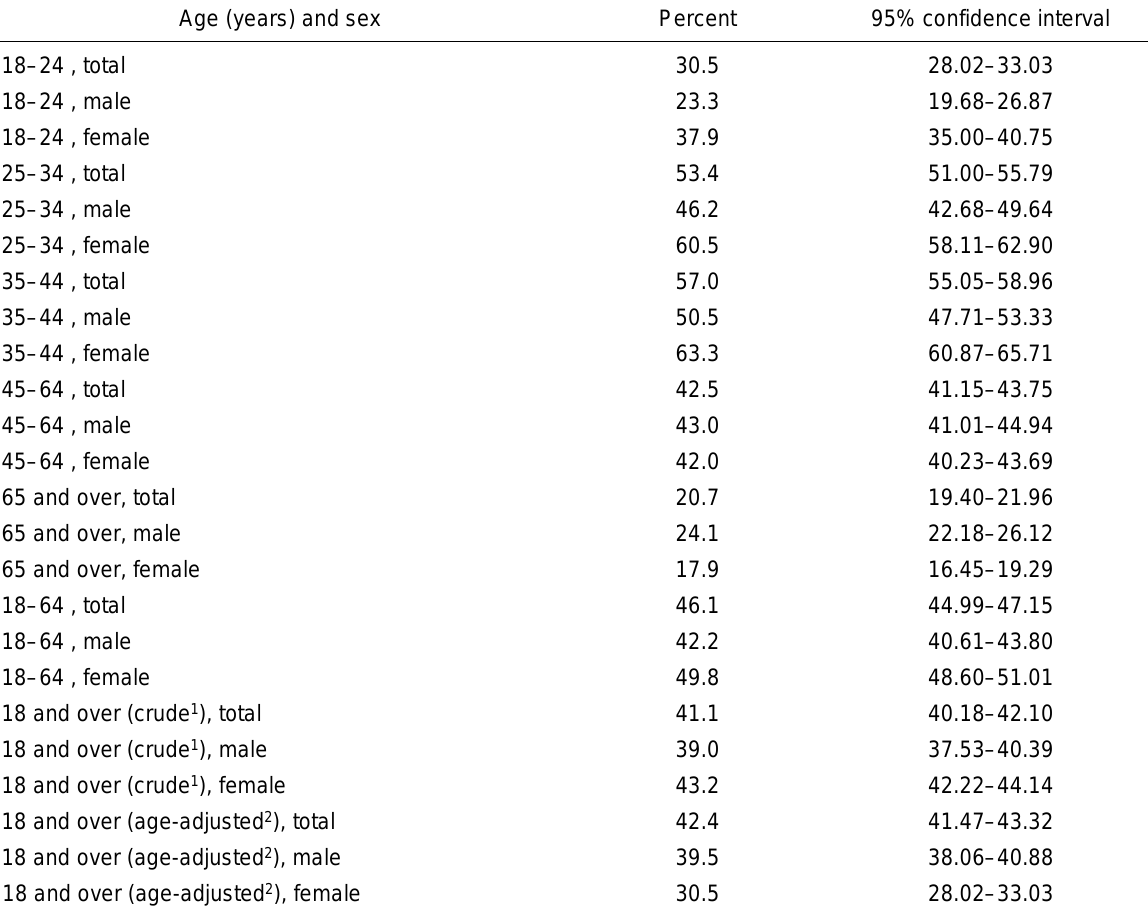
Data table for Figure 10.2. Percentage of adults aged 18 and over who had ever been tested for HIV, by age group and sex: United States,